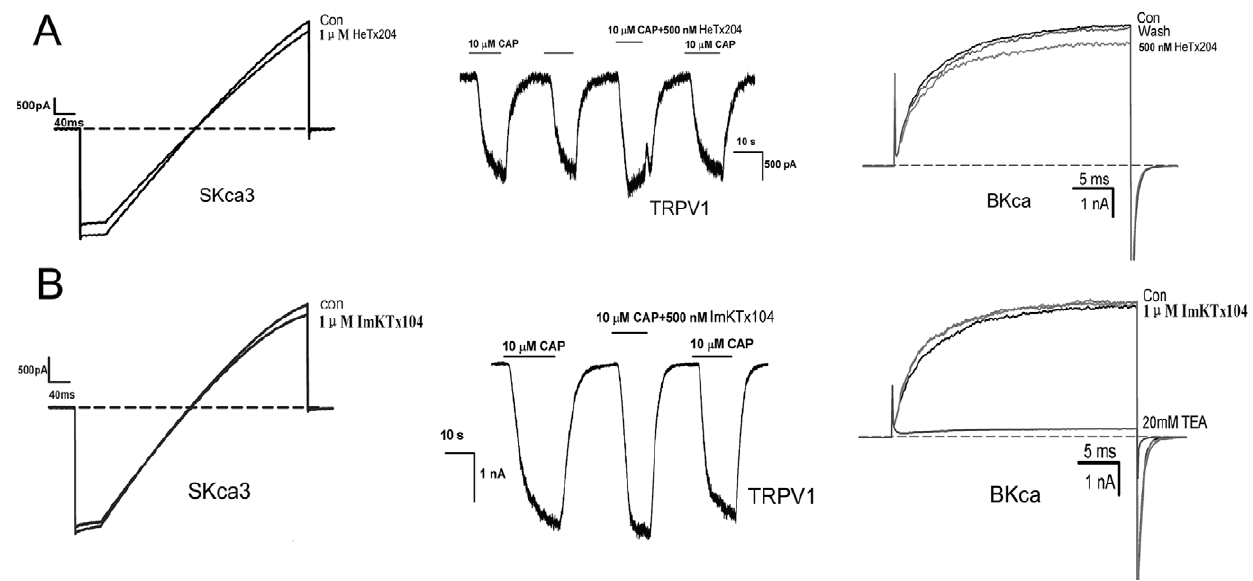
Figure 6. Selectivity of toxins ImKTx104 and HeTx204. (A) Inhibition of SKCa, TRPV1, and BKCa channel currents with 1 m M HeTx204; (B) Inhibition of SKCa, TRPV1, and BKCa channel currents with 1 m M ImKTx104. Representative results are shown (n . 3).